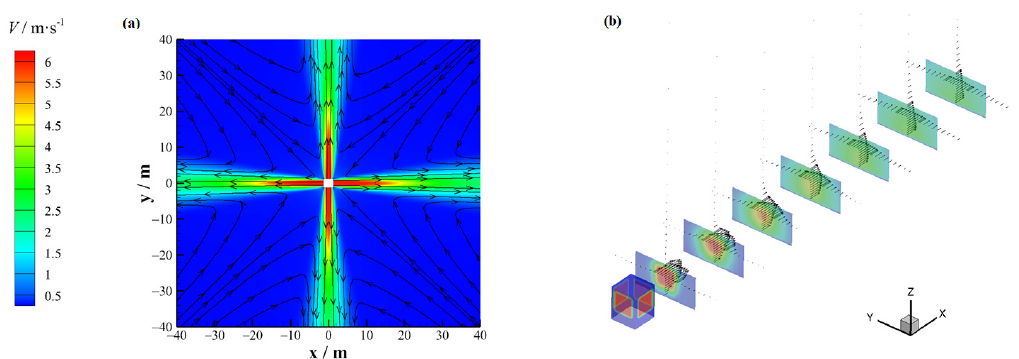
Figure 12. ( a ) Flow structure and ( b ) velocity vector of the horizontal outlet when V 0 = 6 m/s without considering the ambient wind.